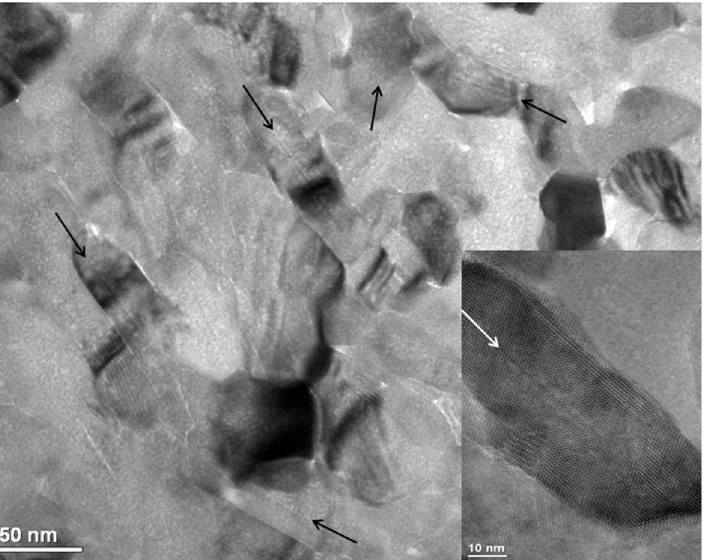
Figure 1. TEM image of human tooth enamel. The Inset shows the high-resolution TEM (HRTEM) image of one of these crystals. The arrows indicate the central dark line (CDL) positions.